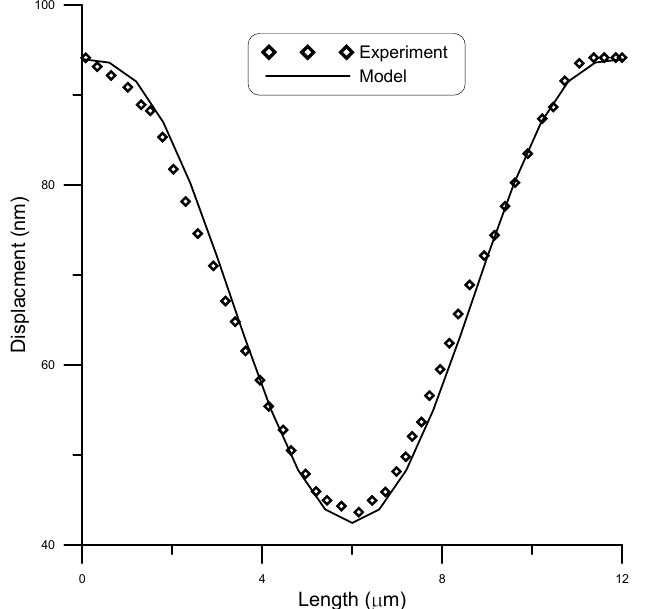
Figure 7. Displacement of a 12 µ m long beam of 190 nm diameter under point load of 81 nN, compared to experimental data [25].